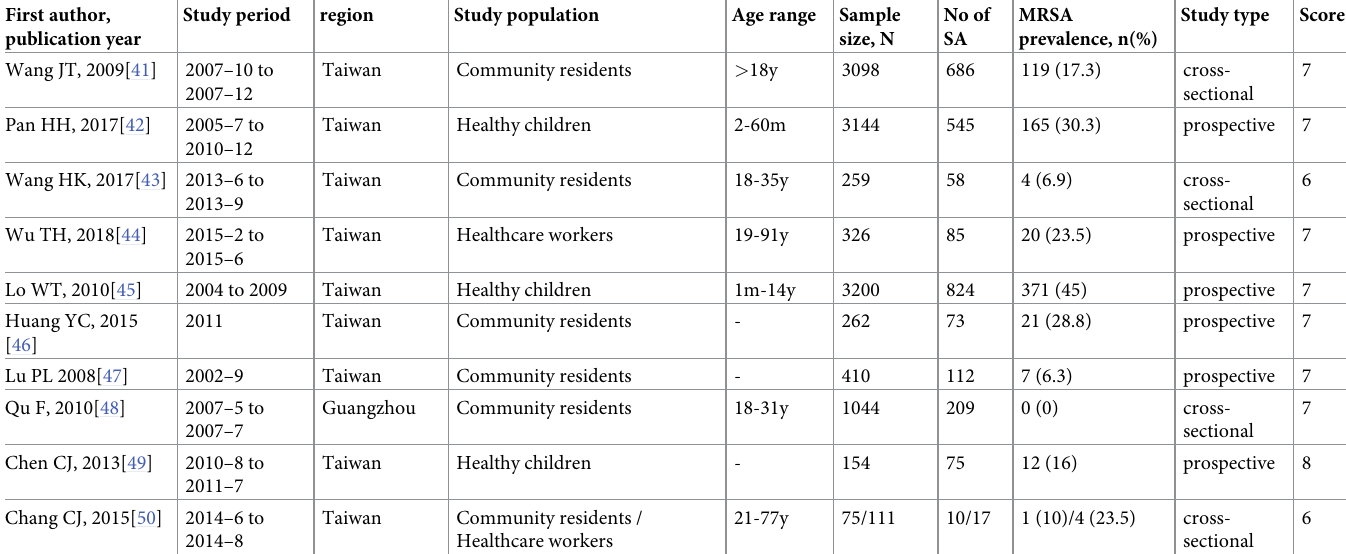
Subgroup analyses. Subgroup analyses were conducted by age range, region, study period, method, and study population. All the pooled prevalence of MRSA and corresponding 95% CI of subgroups were obtained, which were showed in Table 2. Among these subgroups, heterogeneity did still exist, except in Hong Kong. Significant differences were also found across study population (P = 0.03), methods (P < 0.001), and regions (P < 0.001). The pooled prevalence of MRSA was 28% (95%CI: 10%-51%, I 2 = 86.9%) for Livestock-related workers, 18% (95%CI: 11%-26%, I 2 = 98.53%) for children, 20% (95%CI: 12%-29%, I 2 = 82.61%) for healthcare workers, 7% (95%CI: 3%-13%, I 2 = 94.88%) for community residents and 11% (95%CI: 6%-18%, I 2 = 84.76%) for medical students (Fig 5). In view of different MRSA identi- fication methods, the pooled prevalence in studies was 28% (95%CI: 21%-35%) with oxacillin disk diffusion method, followed by others (22%, 95%CI: 14%-31%, I 2 = 96.3%), mecA gene method (12%, 95%CI: 7%-19%, I 2 = 93.91%), cefoxitin disk diffusion method (10%, 95%CI: 4%-18%, I 2 = 95.43%), and the minimum was 8% (95%CI: 3%-16%) with oxacillin agar dilu- tion method (Fig 6). In addition, MRSA proportion was higher in studies conducted in Taiwan than Mainland China and Hong Kong (Fig 7). On the other hand, significant differences were not found across the study period and age ranges (S1 File). Meta-regression for the prevalence of MRSA. The meta-regression was performed to identify related potential influencing factors of inter-heterogeneity, which was showed in Table 3. The meta-regression (residual I 2 = 99.49%, adj R 2 = 12.15%, P = 0.028 in the test for the goodness of model fit) showed that compared with Taiwan, the prevalence of MRSA was significantly lower in Mainland China (OR = 0.43, 95%CI: 0.2–0.92, P = 0.003), and Hong Kong (OR = 0.26, 95%CI: 0.08–0.84, P = 0.026). In addition, the prevalence of MRSA was higher among Livestock-related workers (OR = 4.54, 95%CI: 1.23–16.77, P = 0.024), children (OR = 2.85, 95%CI: 1.19–6.83, P = 0.02) and healthcare workers(OR = 3.67, 95%CI: 1.31–9.79, P = 0.011) than community residents. Influencing factors. Among the 37 articles, only seven studies reported risk factors for MRSA carriage among healthy Chinese population. The significant risk factors were identified